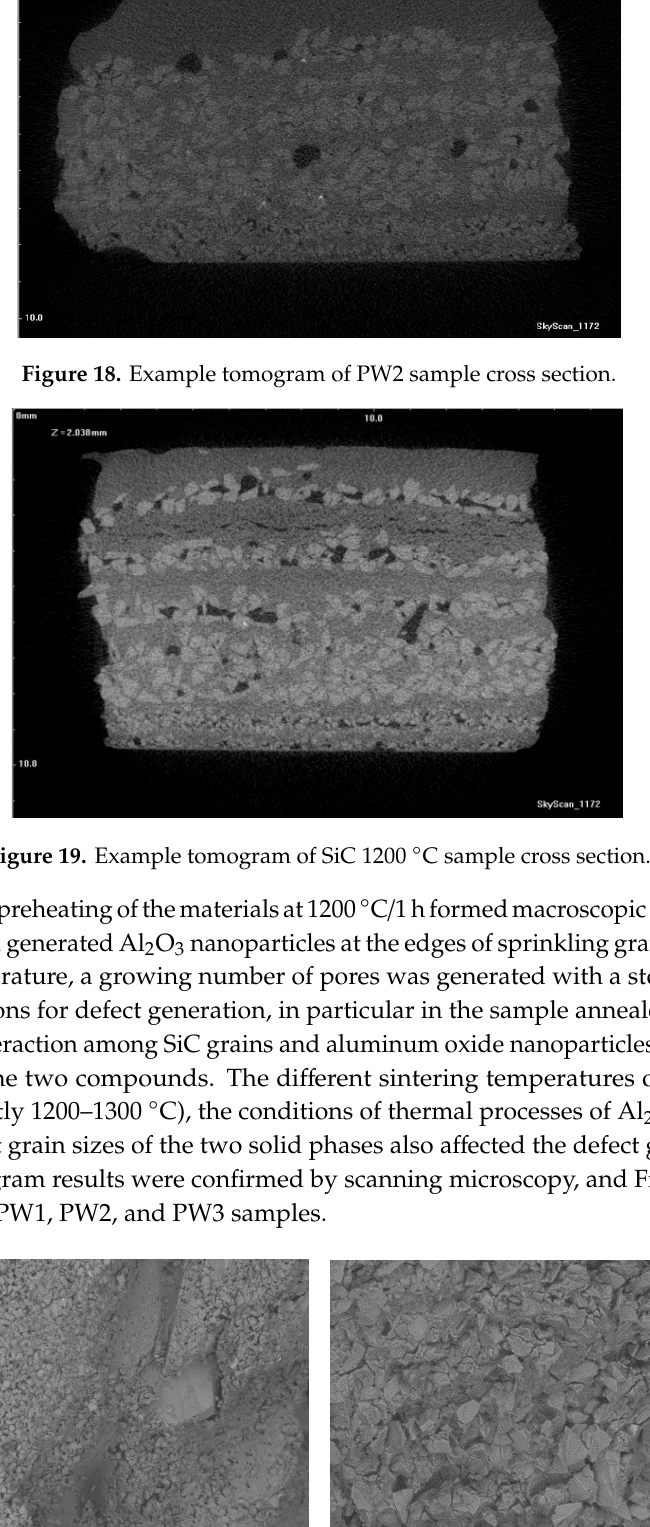
Figure 17. Example tomogram of PW1 sample cross section.